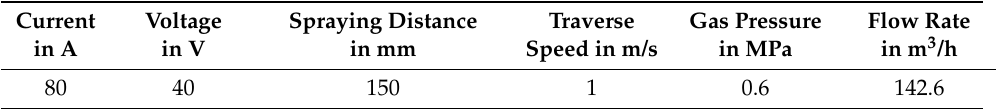
Table 2. Thermal spraying parameters